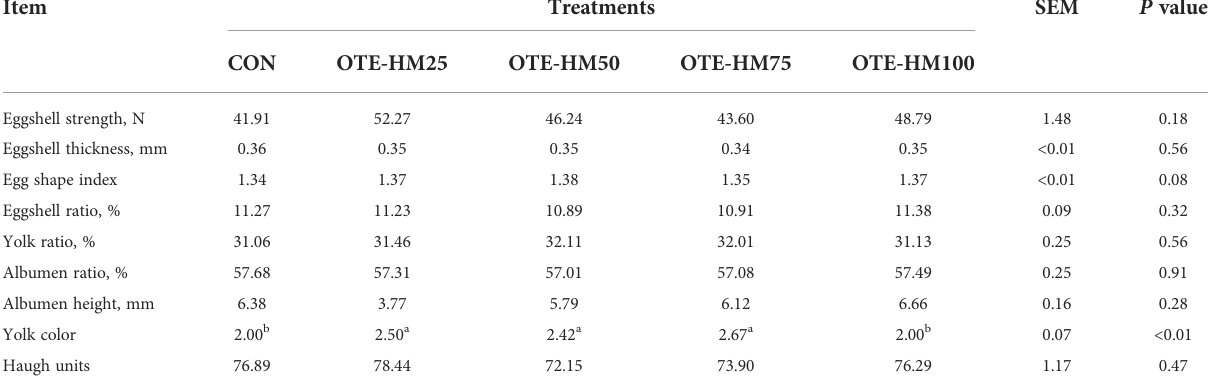
TABLE 3 Effects of experimental diets on egg quality of laying ducks 1